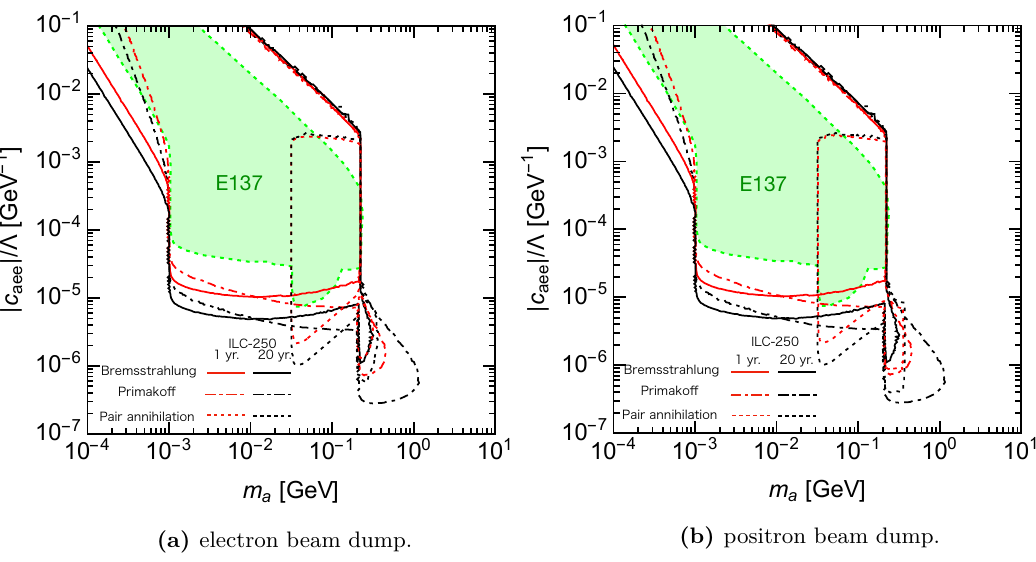
Figure 6. The same plot as figure 4 but for Case II.